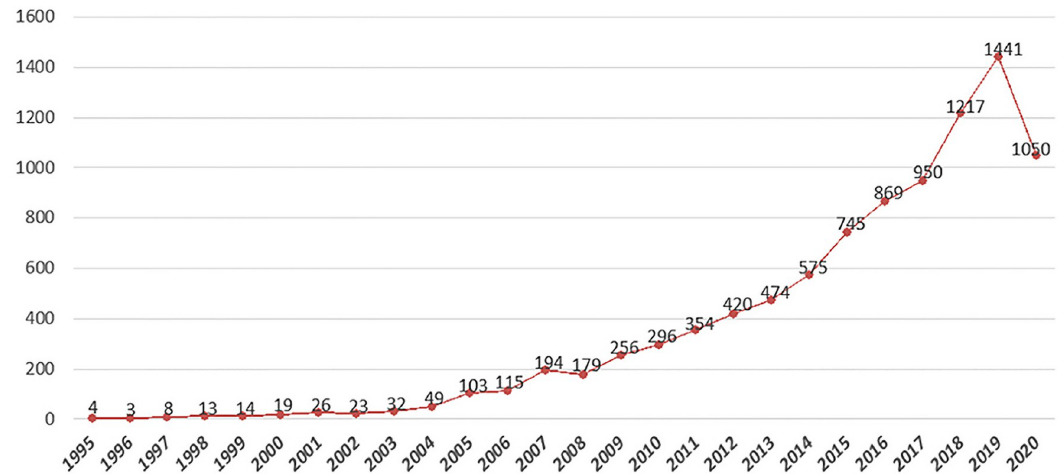
Fig 2. Health literacy trends from 1995 to 2020. In the past 26 years, a total of 9,492 articles on health literacy were published in the WoS Core Collection.